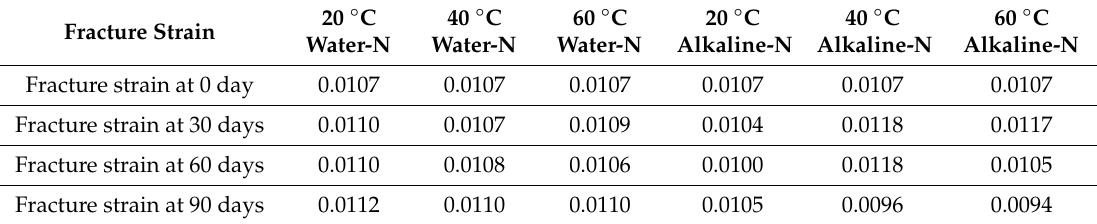
Table 5. Fracture strain of coated immersed specimens.